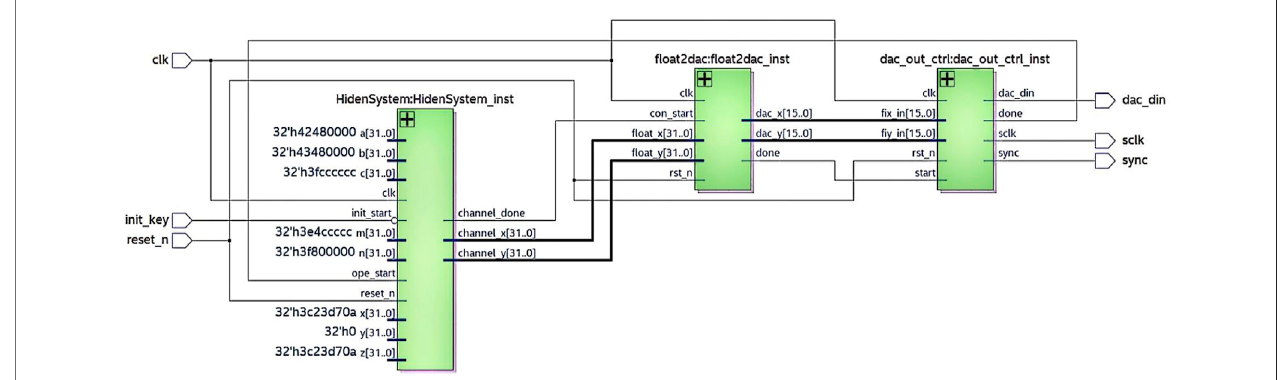
FIGURE 6 | System chart based on the FPGA implementation.